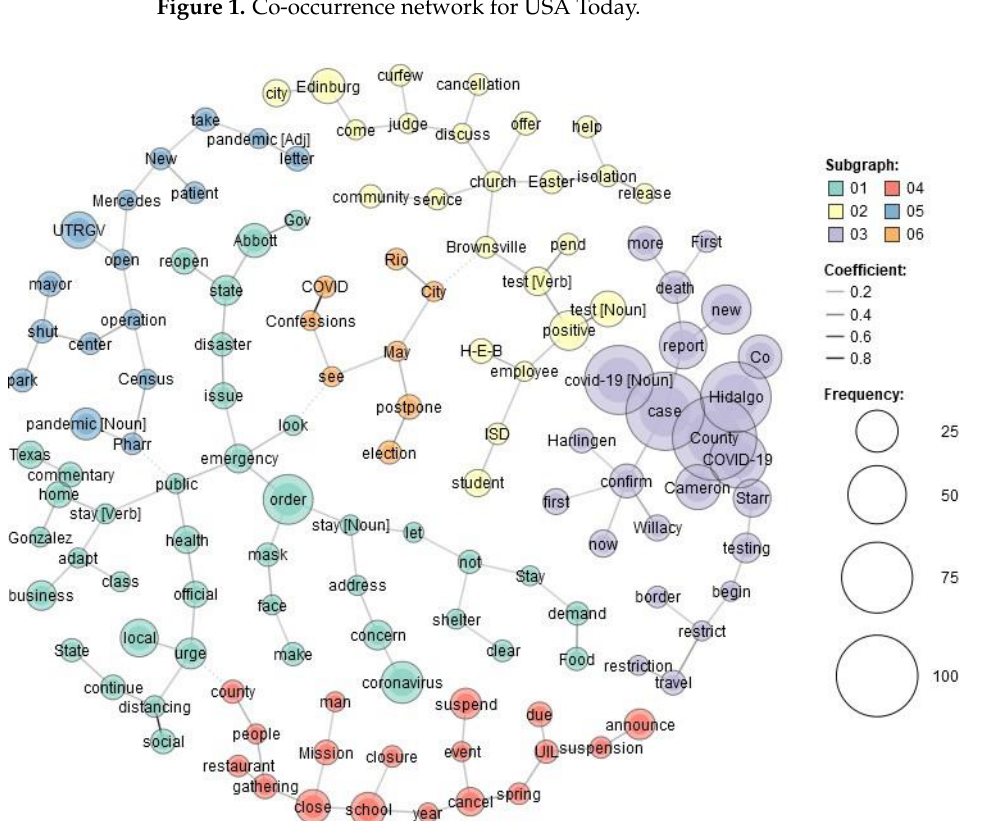
Figure 2. Co-occurrence network for The Monitor.